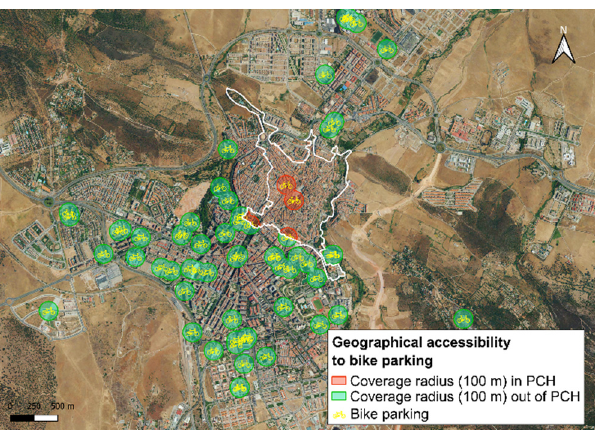
Figure 4. Map of accessibility to bike parking distance